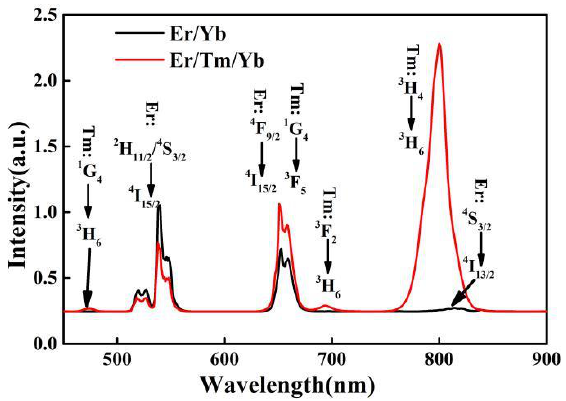
Figure 2. Up-conversion spectra of the samples under 980 nm laser excitation (5 W/cm 2 )